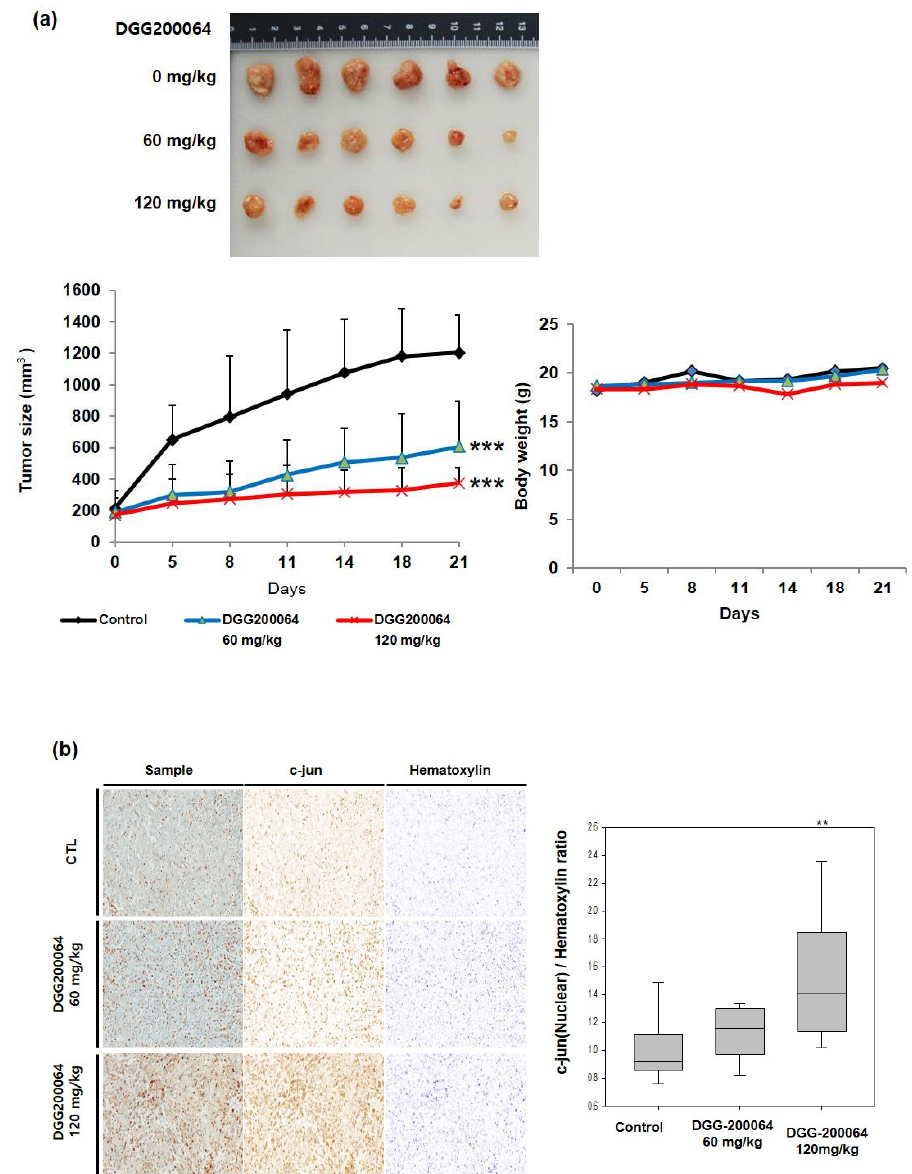
Figure 6. In vivo evaluation of the DGG200064 suppressed colon cancer tumor growth against HCT116 cells. ( a ) HCT116 cell suspensions were injected subcutaneously into 6 weeks old female nude BALB/c mice. When the tumors reached a volume of 100 mm 3 , treatment with DGG200064 was started. ( b ) Colon cancer tumors harvested from nude BALB/c mice were analyzed by immuno- histochemical staining with Hematoxylin and c-Jun antibodies. After the treatment with DGG200064 , 0.1 mL BrdU in sterile DPBS was injected intraperitoneally. Then, 2 h later, the animals were anesthetized, perfused with PBS, and killed. The colon cancer tumors were then excised ** p < 0.01, *** means p -value.